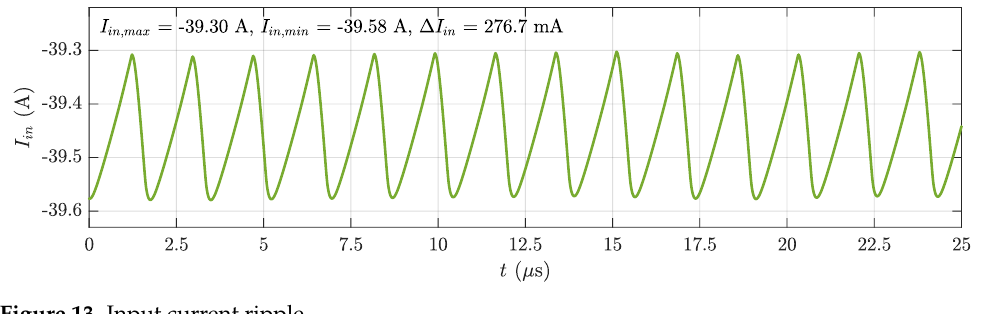
Figure 13. Input current